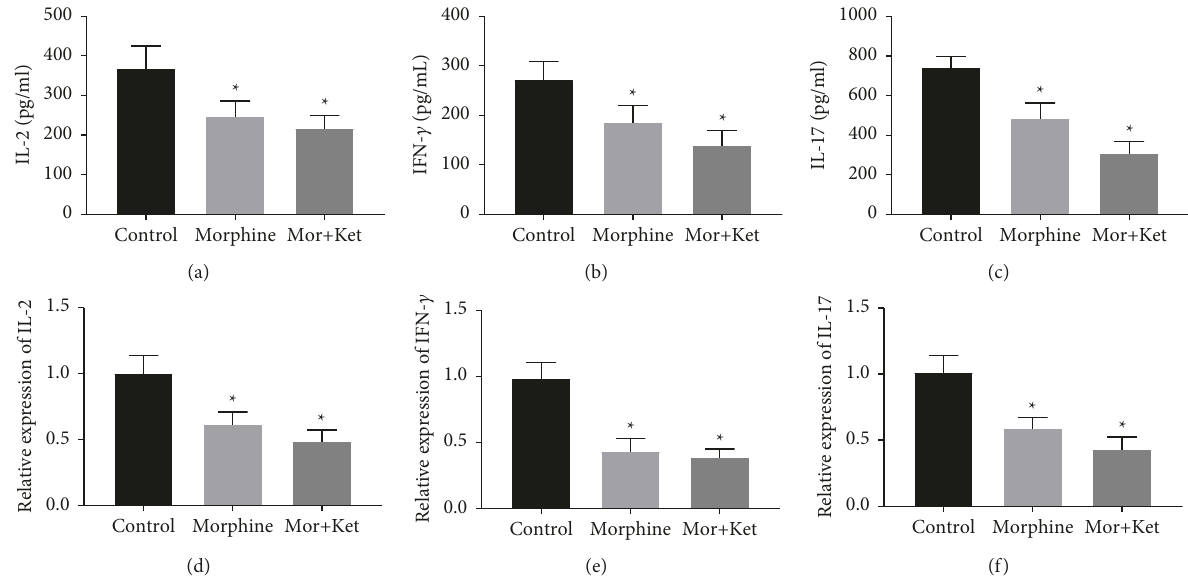
Figure 3: Morphine and ketamine inhibit the secretion of IL-2, IFN- c , and IL-17 in vitro. (a) The level of IL-2 measured by ELISA. (b) The level of IFN- c measured by ELISA. (c) The level of IL-17 measured by ELISA. (d) The mRNA expression of IL-2 detected by qRT-PCR. (e) The mRNA expression of IFN- c detected by qRT-PCR. (f) The mRNA expression of IL-17 detected by qRT-PCR. ∗ P < 0 . 05 vs. the control group.